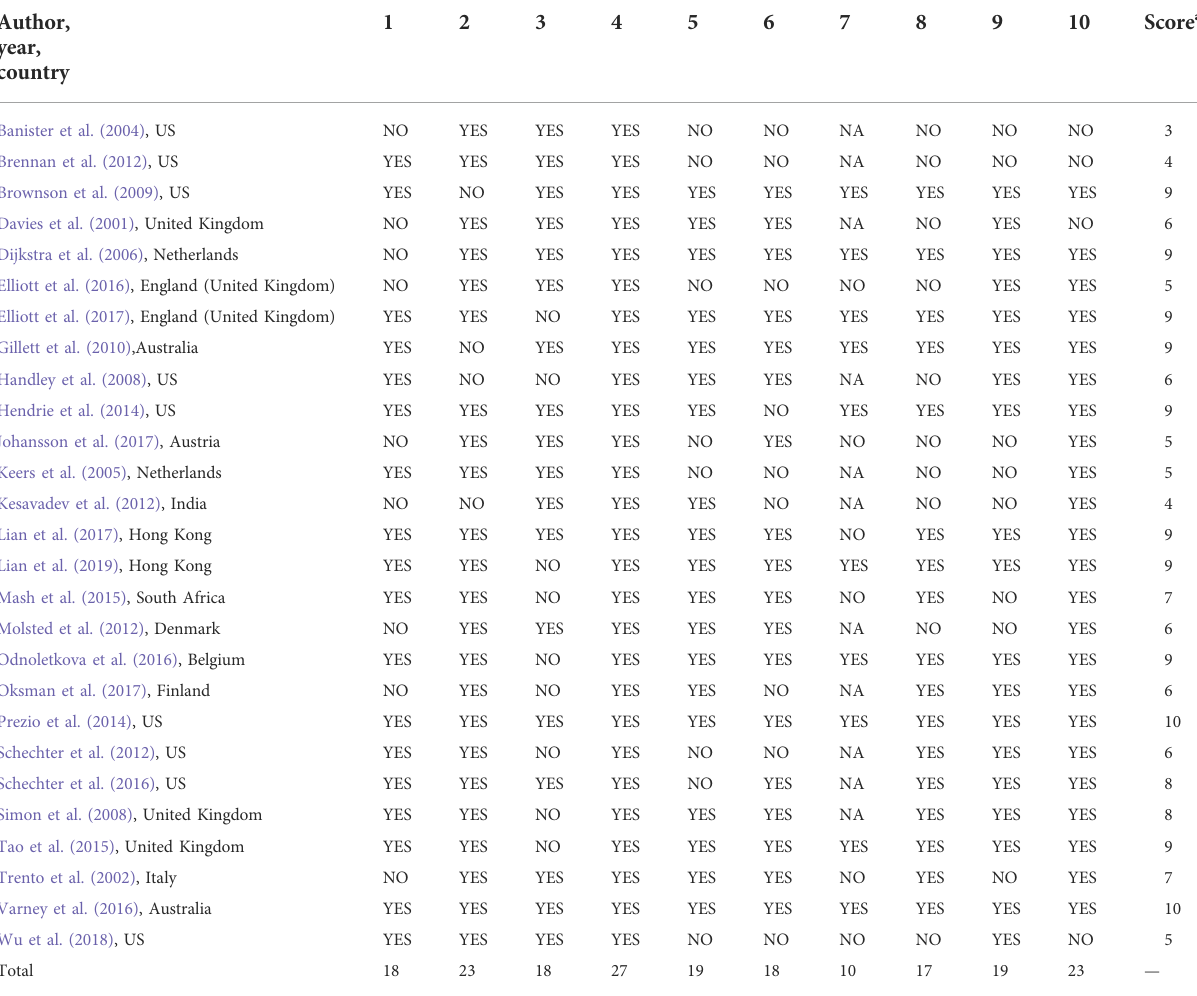
TABLE 3 Quality assessment of a systematic review of the cost-effectiveness of different types of educational interventions in type II diabetes